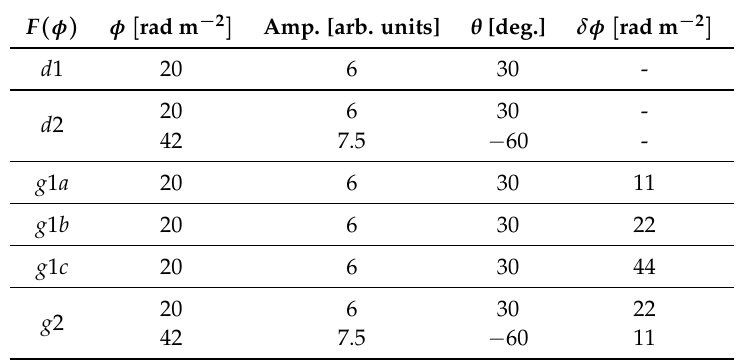
Table 2. The parameters of the assumed F ( φ ) models used to generate the mock data. Amp. is the amplitude, θ is the polarization angle and δφ is the standard deviation of the component for the Gaussian function. Note that the amplitude for Gaussians is the integrated value in φ space. For two-component F ( φ ) , namely d 2 and g 2, parameters for both components are shown. F ( φ ) φ [ rad m − 2 ] Amp. [arb. units] θ [deg.] δφ [ rad m − 2 ] d 1 20 6 30 - 20 6 30 - d 2 42 7.5 − 60 - g 1 a 20 6 30 11 g 1 b 20 6 30 22 g 1 c 20 6 30 44 20 6 30 22 g 2 42 7.5 − 60